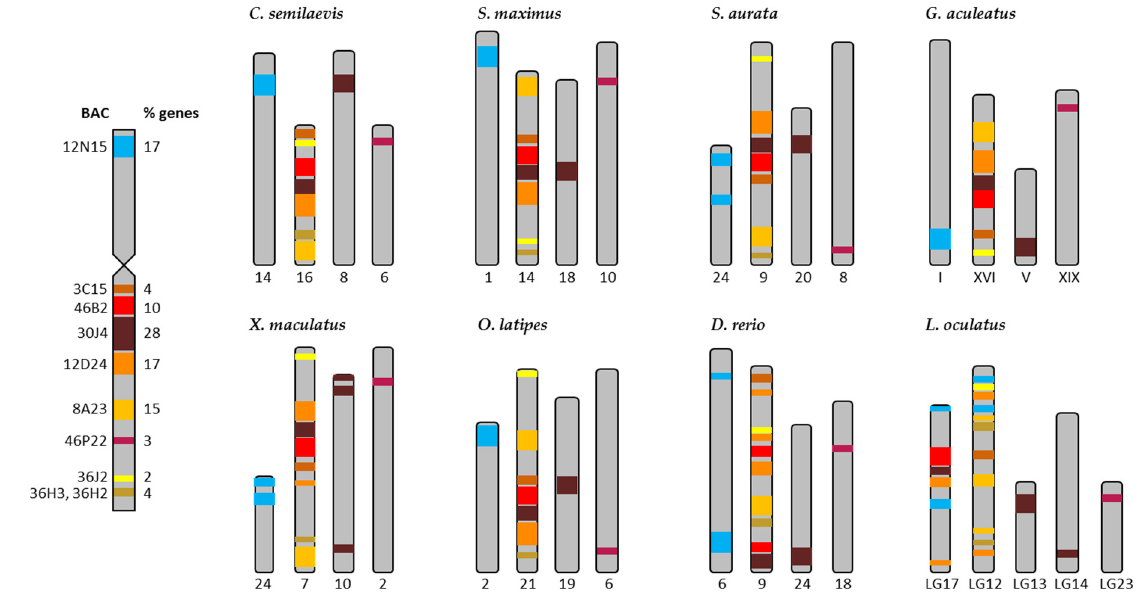
Figure 4. Distribution of the BACs of the submetacentric chromosome 4 of Solea senegalensis in the chromosomes of the eight reference fish species: Cynoglossus semilaevis , Scophthalmus maximus , Sparus aurata , Gasterosteus aculeatus , Xiphophorus maculatus , Oryzias latipes , Danio rerio, and Lepisosteus oculatus . The colors represent the different BACs in the chromosome 4. % of genes is referred to the number of genes in each BAC, in respect to the total of the genes in chromosome 4 (69 genes).